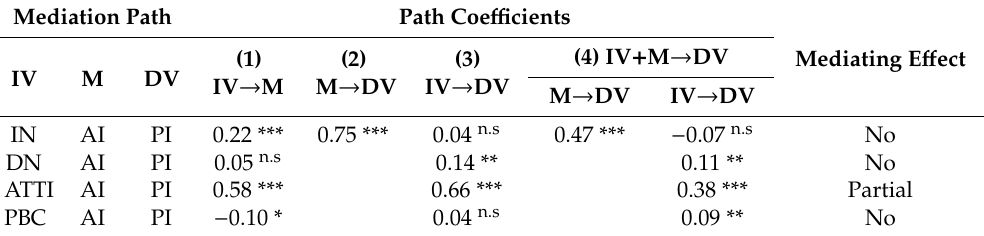
Table 5. Testing of the mediating e ff ect (BK